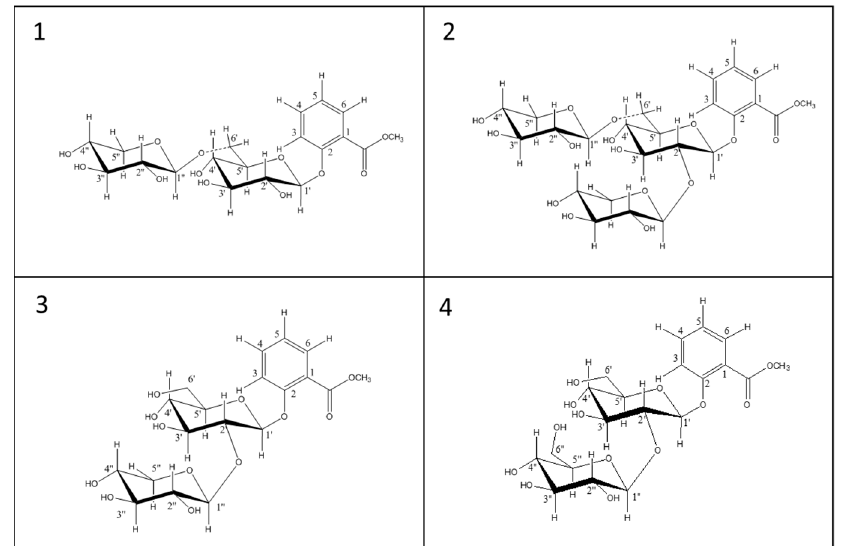
Figure 4. Structural formulas of the compounds isolated from the dried leaves of Gaultheria procumbens L . MeSA β - D -xylosyl-(1 → 6)- β - D -glucose (gaultherin) ( 1 ), MeSA xyloyl-[1 → 6]-xylosyl-[1 → 2]-glucose (MeSA-MSTG-A) ( 2 ), MeSA β - D -xylosyl-(1 → 2)- β - D -glucose (sambubiose) ( 3 ), MeSA β - D -glucosyl-(1 → 2)- β - D -glucose (sophorose) ( 4 ) . 1 H-NMR ( 1 , 400 MHz, Methanol-d 4 ): 7.76 (ddd, J = 7.8, 1.8, 0.3 Hz, H-6,1H), 7.57 (ddd, J = 8.4, 7.3,